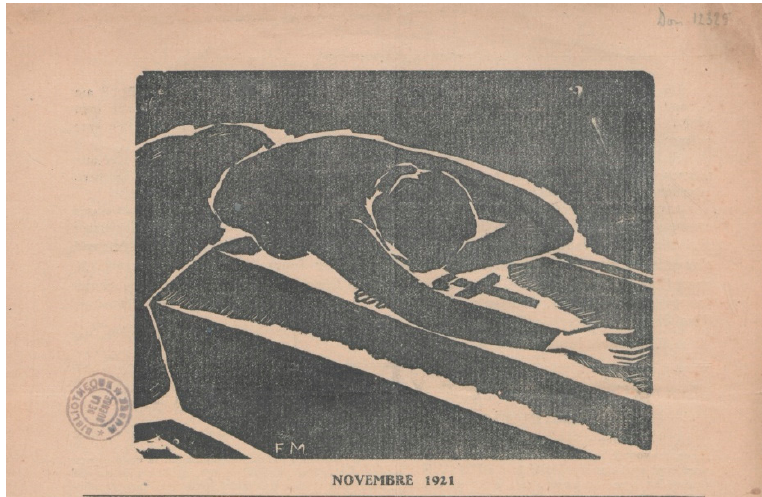
Figure 4. Frans Masereel. Novembre 1921. 1921. Ink on paper. La Contemporaine. Fonds Ligue